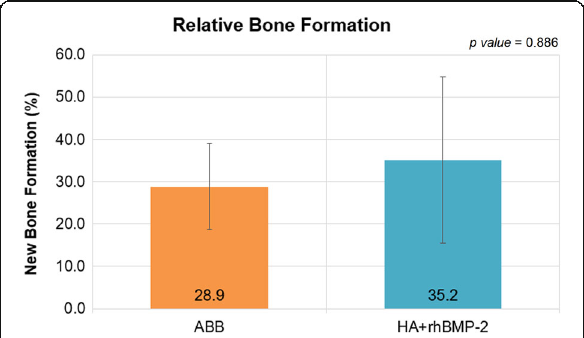
Fig. 4 Relative bone formation. HA+rhBMP-2 group showed more bone formation around the bone graft materials than the ABB group histologically, however, without statistical significance ( p